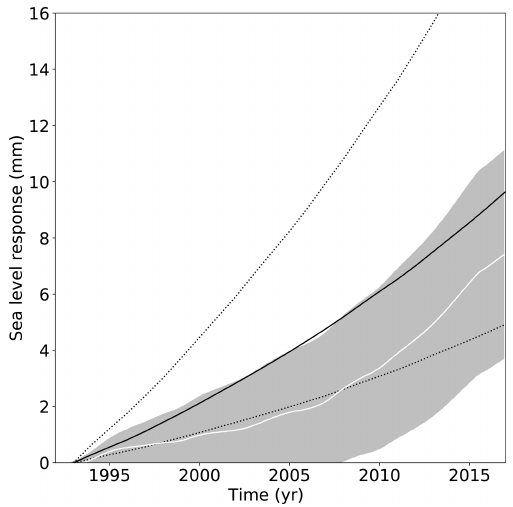
Figure 7. Hindcasting of all models combined with observed sea level contributions and modelled sea level contribution of Antarc- tica from the different ice sheet models. The solid black line rep- resents the median contribution between 1992 and 2017 with the 66th percentile (first standard deviation) around the median. The grey shading represents the uncertainty range of the observed con- tribution of Antarctica (white solid line) following Shepherd et al. (2018).